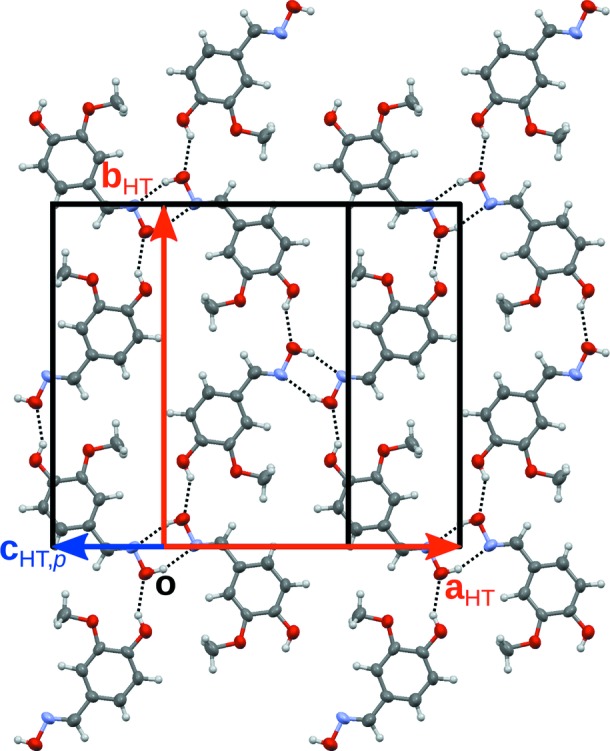
The crystallochemical layer in the HT phase of 1
 projected onto the (001) layer plane. Equivalent ADP ellipsoids are drawn at the 50% probability level. Strong hydrogen bonds are represented by dashed lines. The atom colour code is as in Fig. 1 ▸. The unit-cell edges are drawn in black. For clarity, lattice vectors in and out of the drawing plane are drawn in red and blue, respectively.